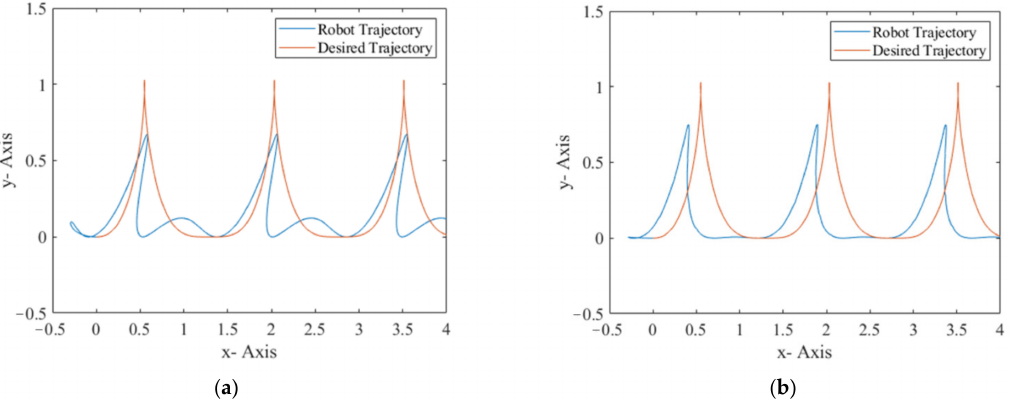
Figure 12. Comparison of ( a ) best simulation with the IT3FC and ( b ) worst simulation with the IT3FC proposed methods with PG